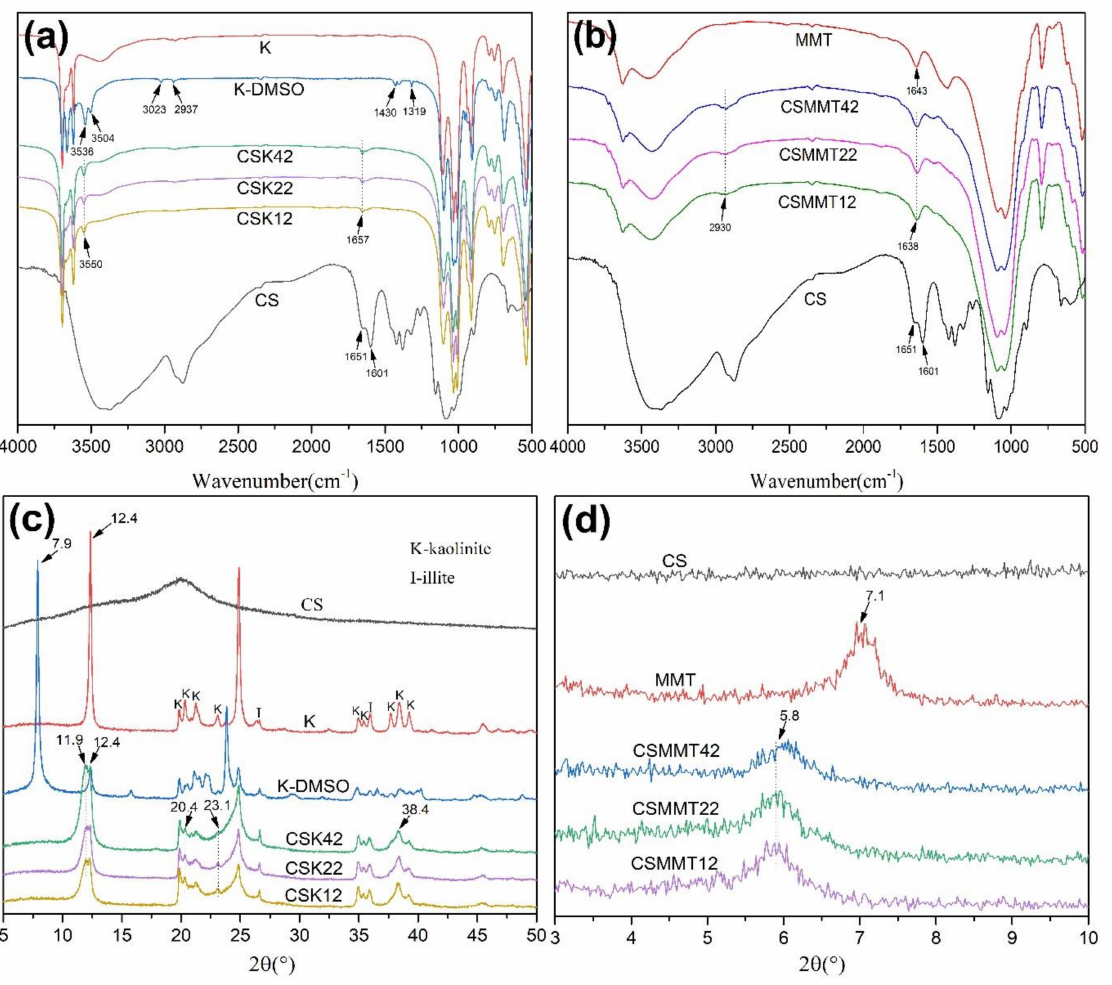
Figure 1. FTIR spectra ( a , b ) and XRD patterns ( c , d ) of CS, K, K − DMSO, CSK42, CSK22, and CSK12 ( a , c ); and MMT, CSMMT42, CSMMT22, and CSMMT12 ( b , d